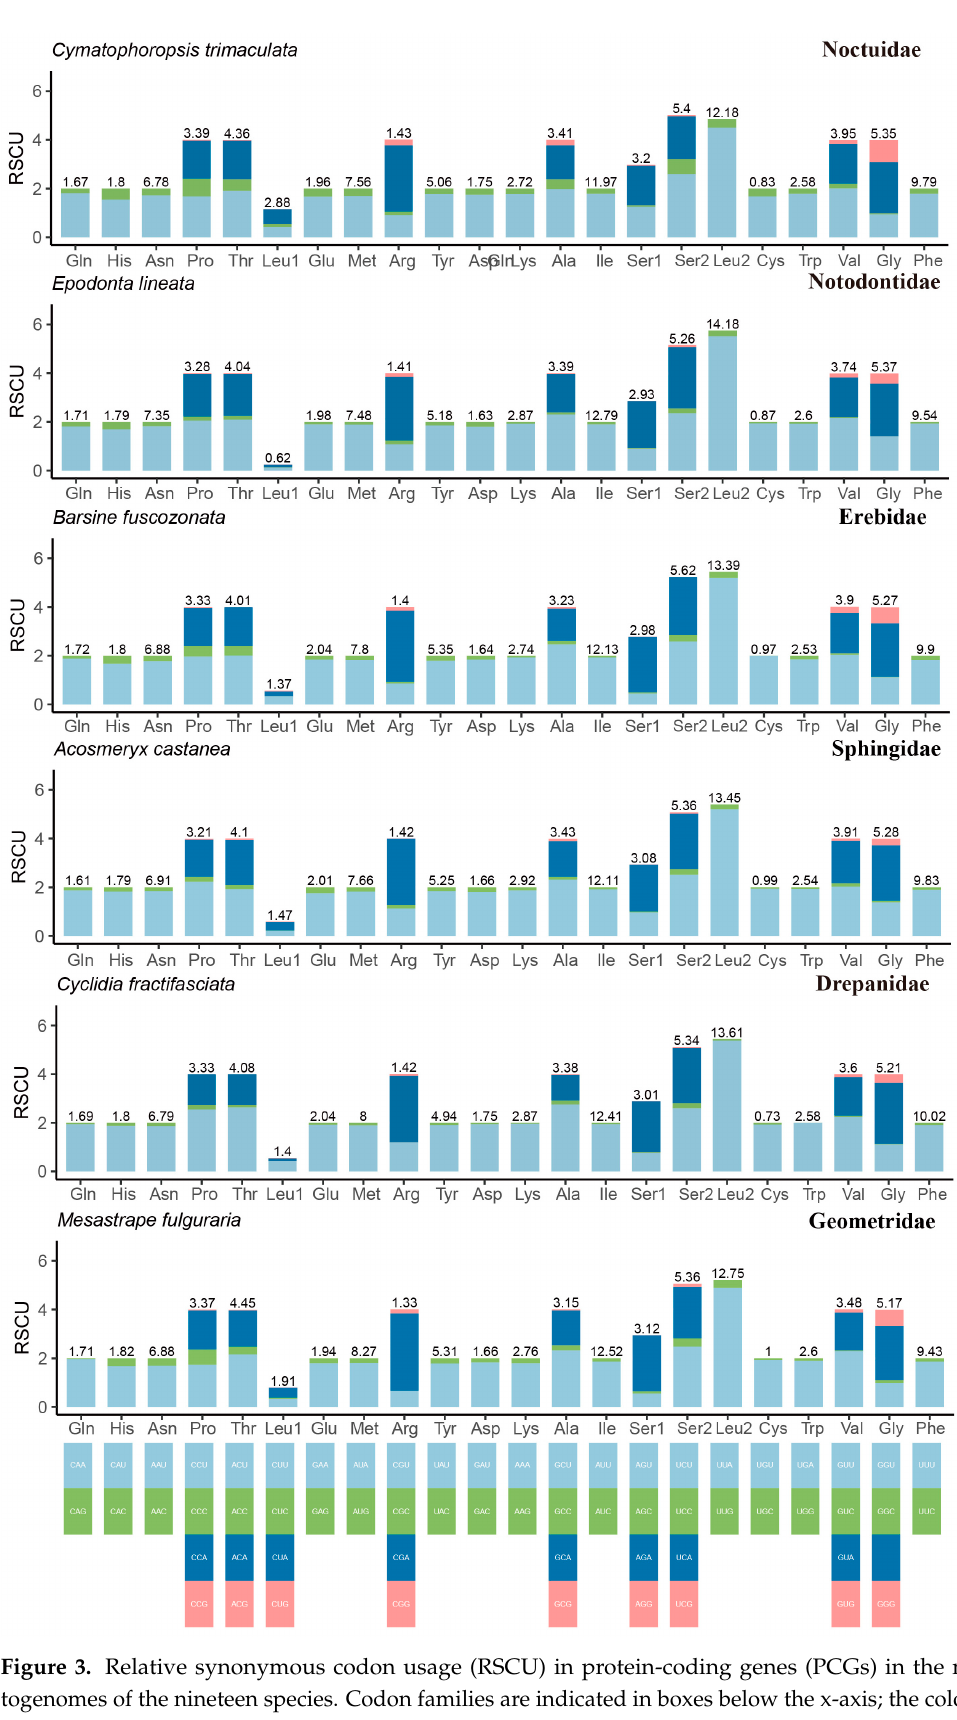
Figure 3. Relative synonymous codon usage (RSCU) in protein-coding genes (PCGs) in the mi- togenomes of the nineteen species. Codon families are indicated in boxes below the x-axis; the colors correspond to the stacked columns, and values on the top of the bars denote amino acid